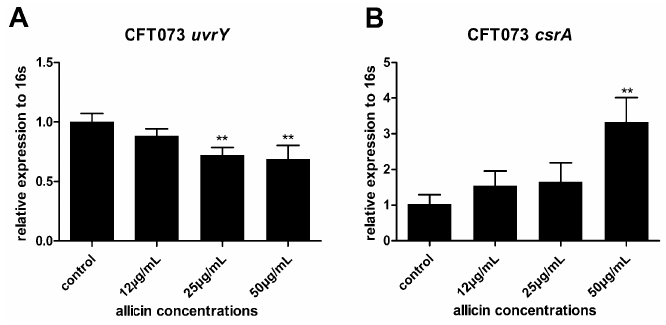
Figure 8. Relative transcript levels of UPEC CFT073 BarA-UvrY gene uvrY ( A ) and its downstream global RNA binding protein gene csrA ( B ) were assessed by RT-qPCR with 16s as an internal control relative to the untreated control set at 1. Bars indicate means ± SD for three independent experiments, ** p < 0.01.